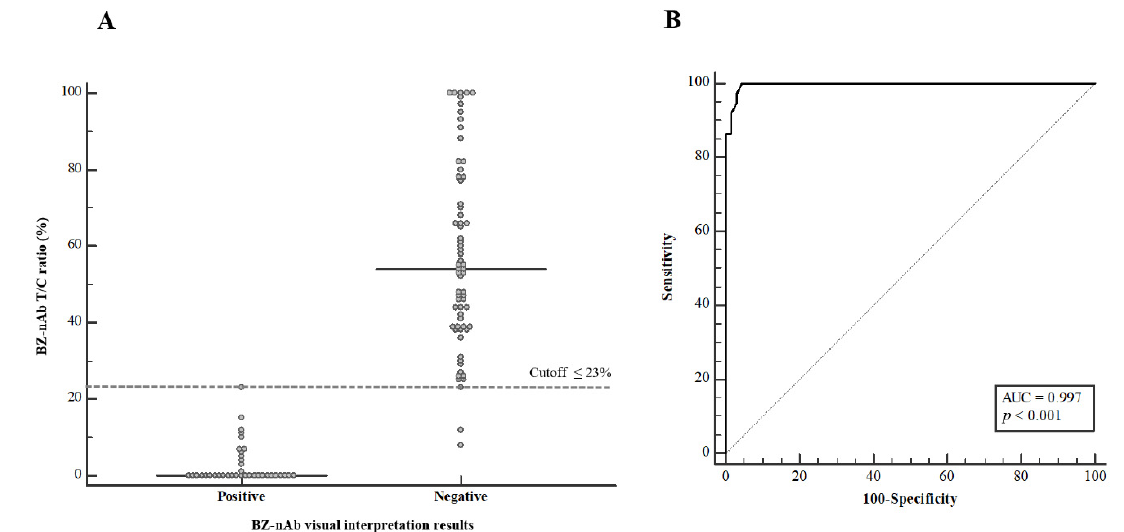
Figure 3. Comparison of the T/C ratio-interpreted and visually interpreted results of the BZ-nAb test. ( A ) Data distribution of BZ-nAb visually interpreted results. The horizontal dashed line indicates the cutoff selected using the receiver operating characteristic (ROC) analysis. ( B ) The ROC curve for the T/C ratio results, compared to the visually interpreted results. The area under the curve (AUC) values are also presented.